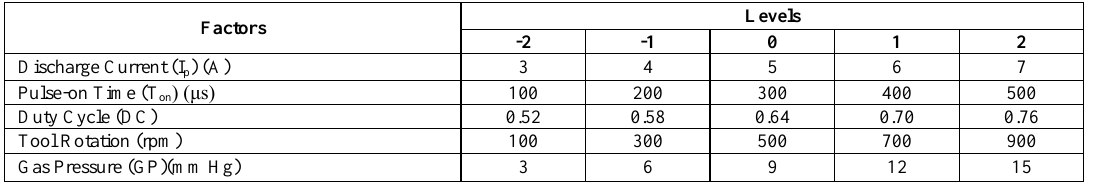
Table 2. Control factors with their levels